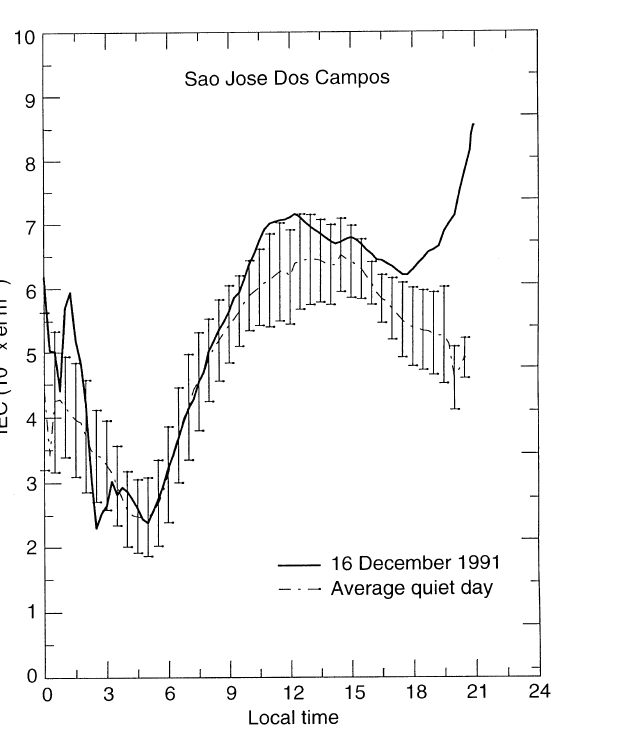
Fig. 4. Diurnal profile of Ionospheric electron content (IEC) at Sa˜ o Jose´ dos Campos, Brazil, derived from measurements of Faraday rotation of 136-MHz beacon transmissions of GOES-1 satellite on 16 December 1991. Also shown is the average diurnal pattern of IEC for quiet days of the month ( dashed curve ) along with standard deviations ( vertical bars ) of